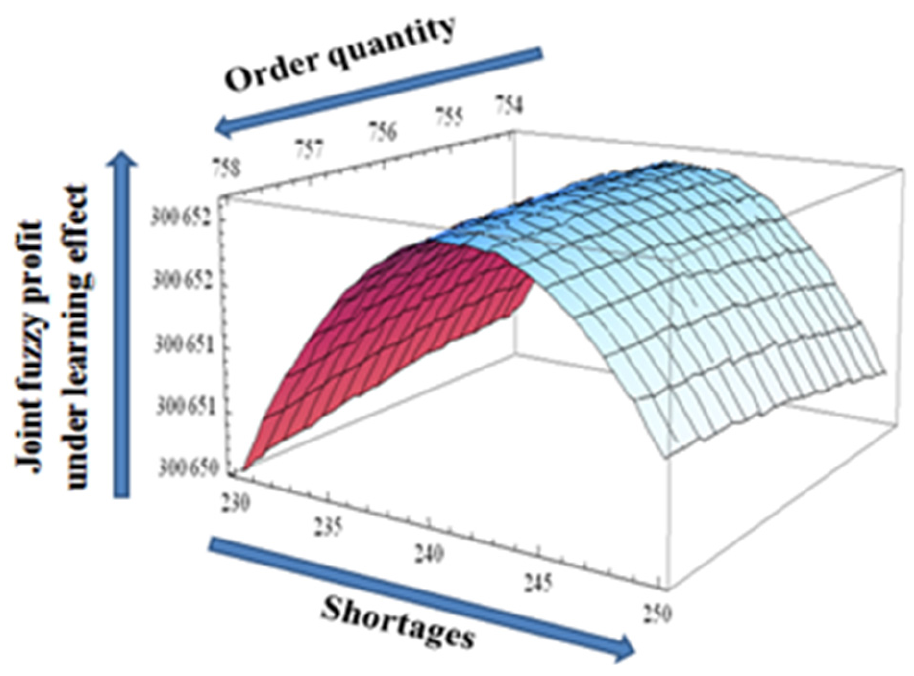
Figure 9. Concavity of the joint fuzzy profit with respect to the order quantity and shortages under learning in a fuzzy environment.